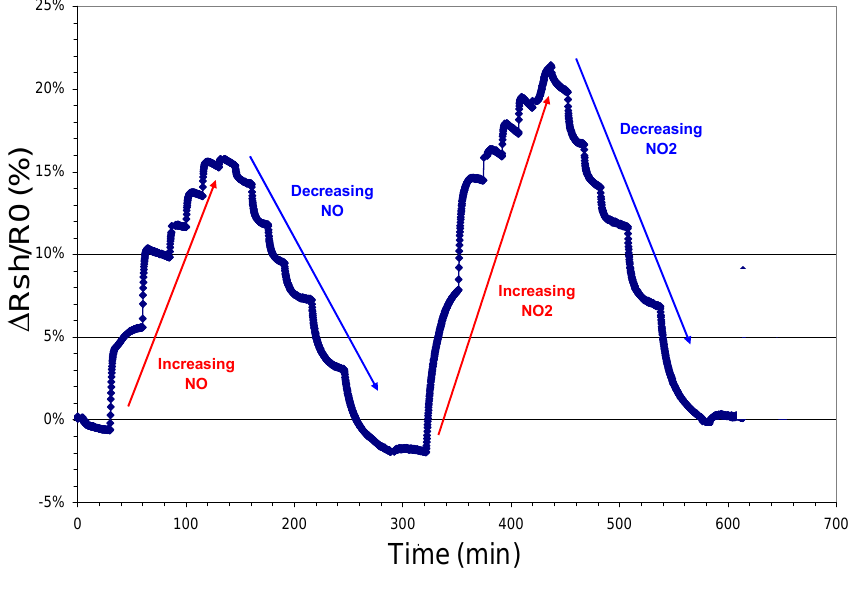
Figure 11. VDP data from a hemin functionalized InAs